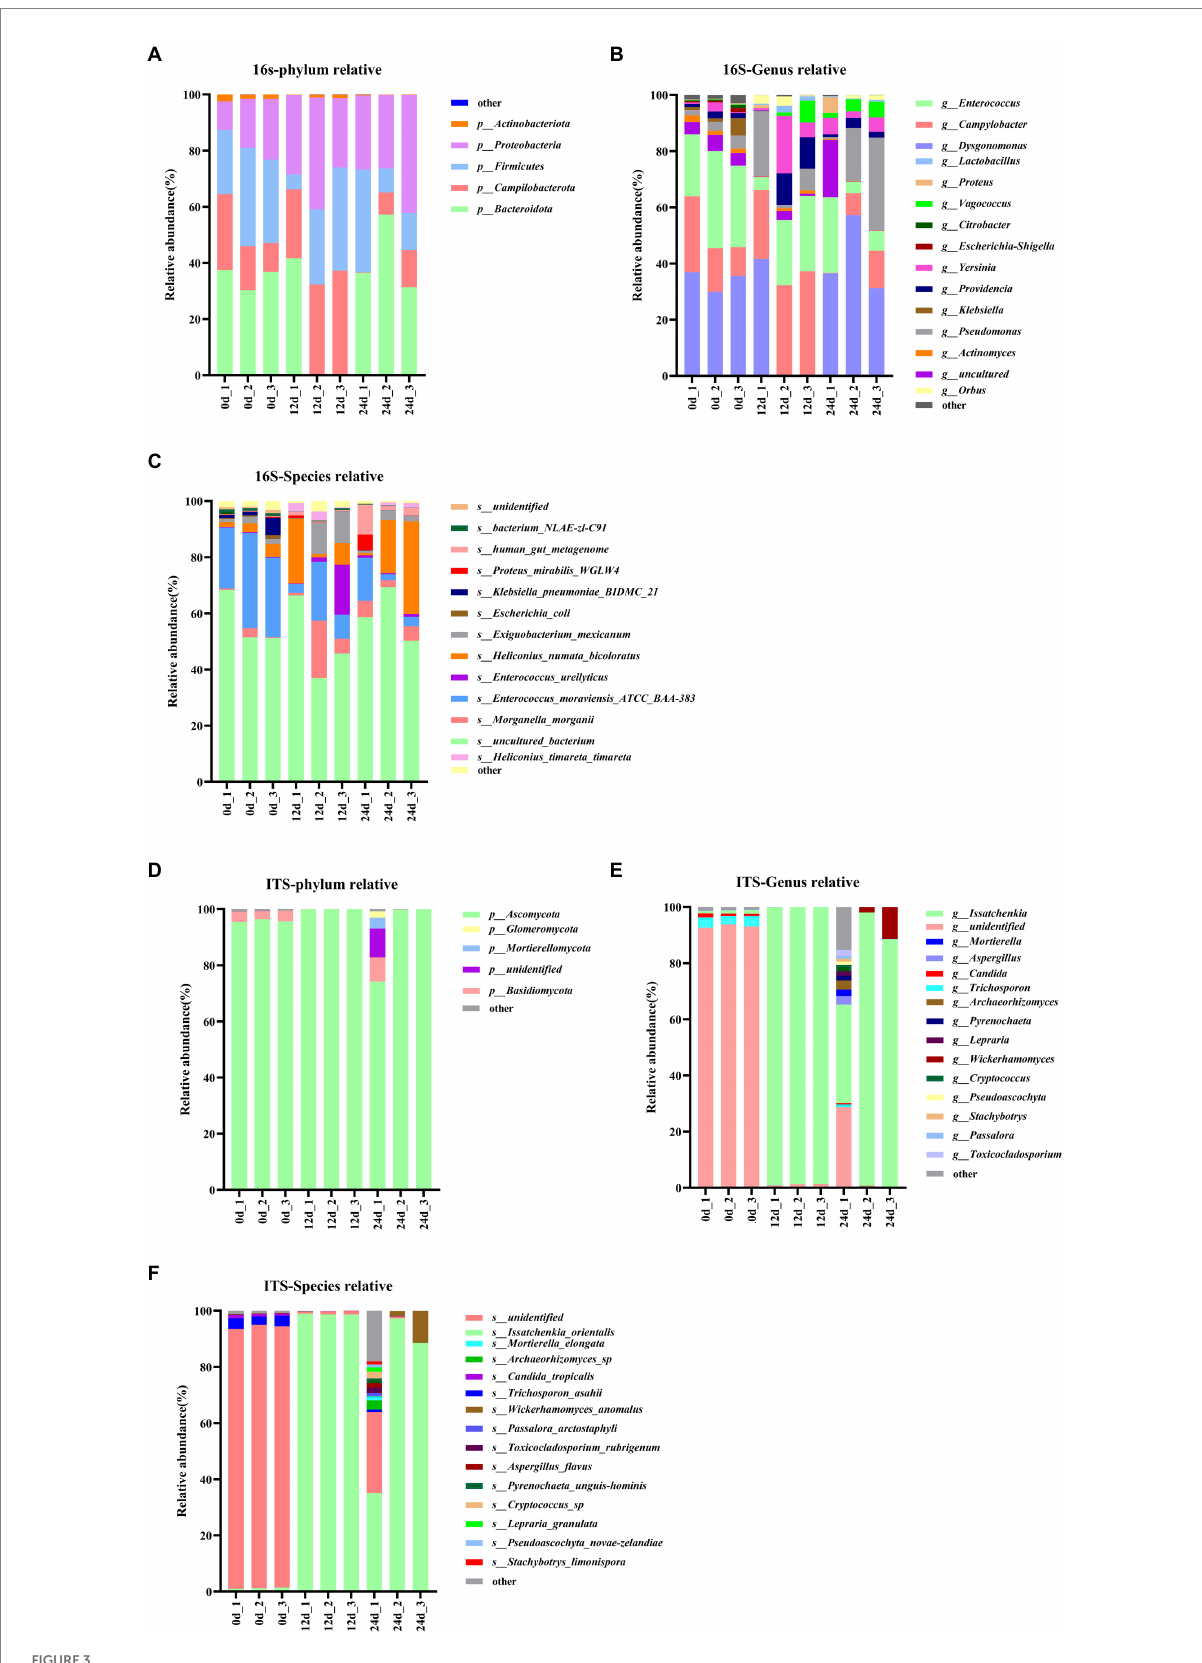
FIGURE 3 Relative abundance changes of core gut microbes, 16S rDNA sequences: (A) Phylum level, (B) genus level, (C) species level; ITS1 sequences: (D) phylum level, (E) genus level, (F) species